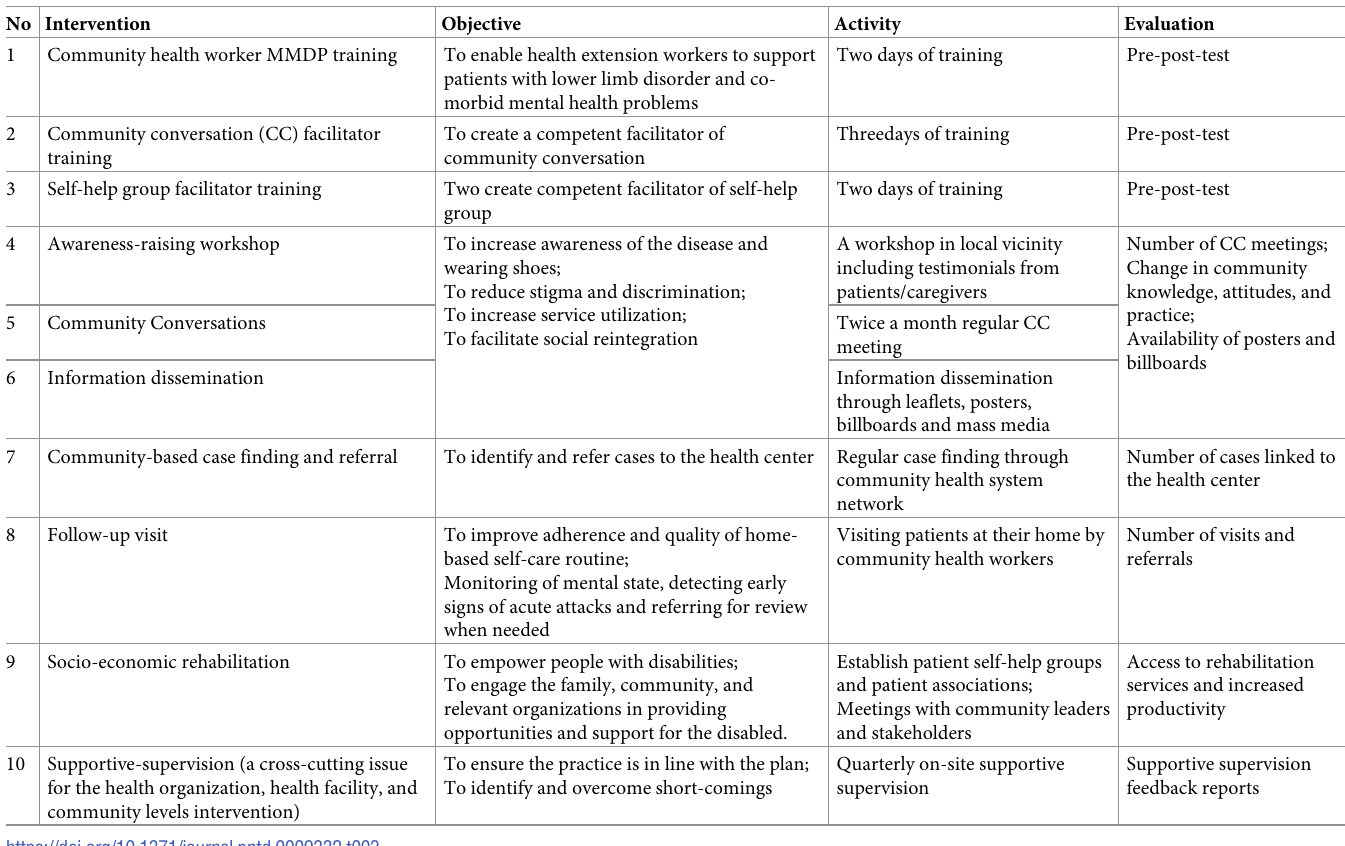
Table 3. Community Interventions.